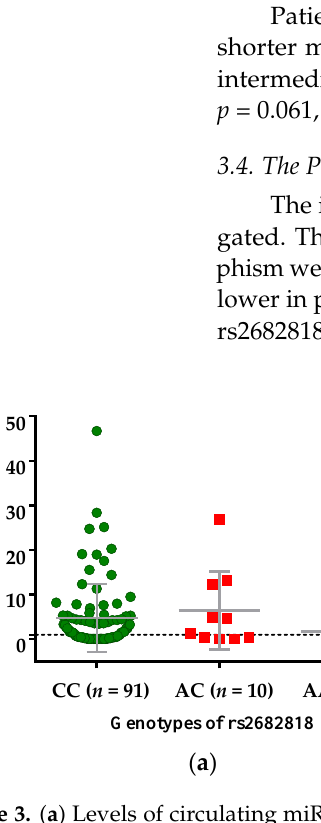
Figure 3. ( a ) Levels of circulating miR-618 in patients with mCC carrying different genotypes of rs2682818. There were no significant differences between rs2682818l genotypes in regard to expression of miR-618 (Mann-Whitney U test, data are presented as mean ± SD). ( b ) Kaplan–Meier survival analysis for assessment of AC vs. CC and AA genetic model of rs2682818 and the overall survival of mCC patients. Patients carrying AA genotype and those carrying CC/AA genotypes did not have statistically different overall survival ( p = 0.893).